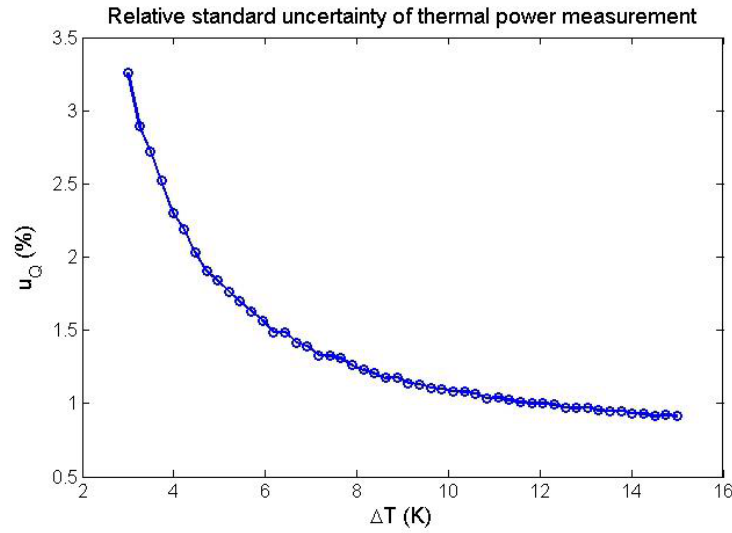
Figure 1. Relative standard uncertainty associated with the thermal power measurement of a particular reference direct heat meter at the INRIM central heating system test